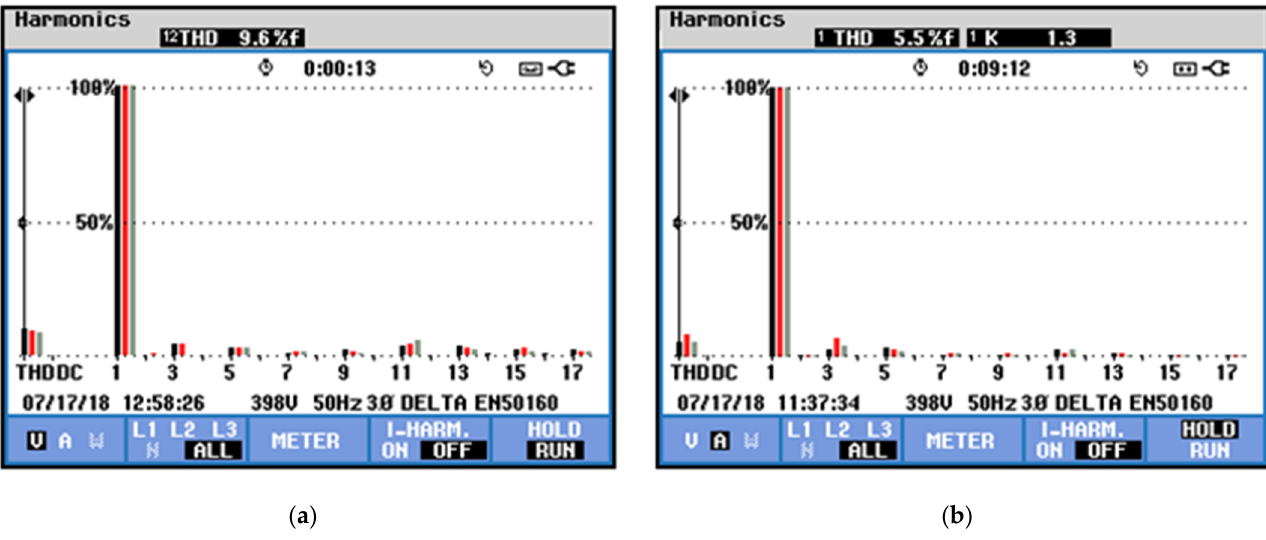
Figure 13. ( a ) THD voltage results in the AC offshore link grid—CIS Control; ( b ) THD current results in the AC offshore link grid—CIS control.